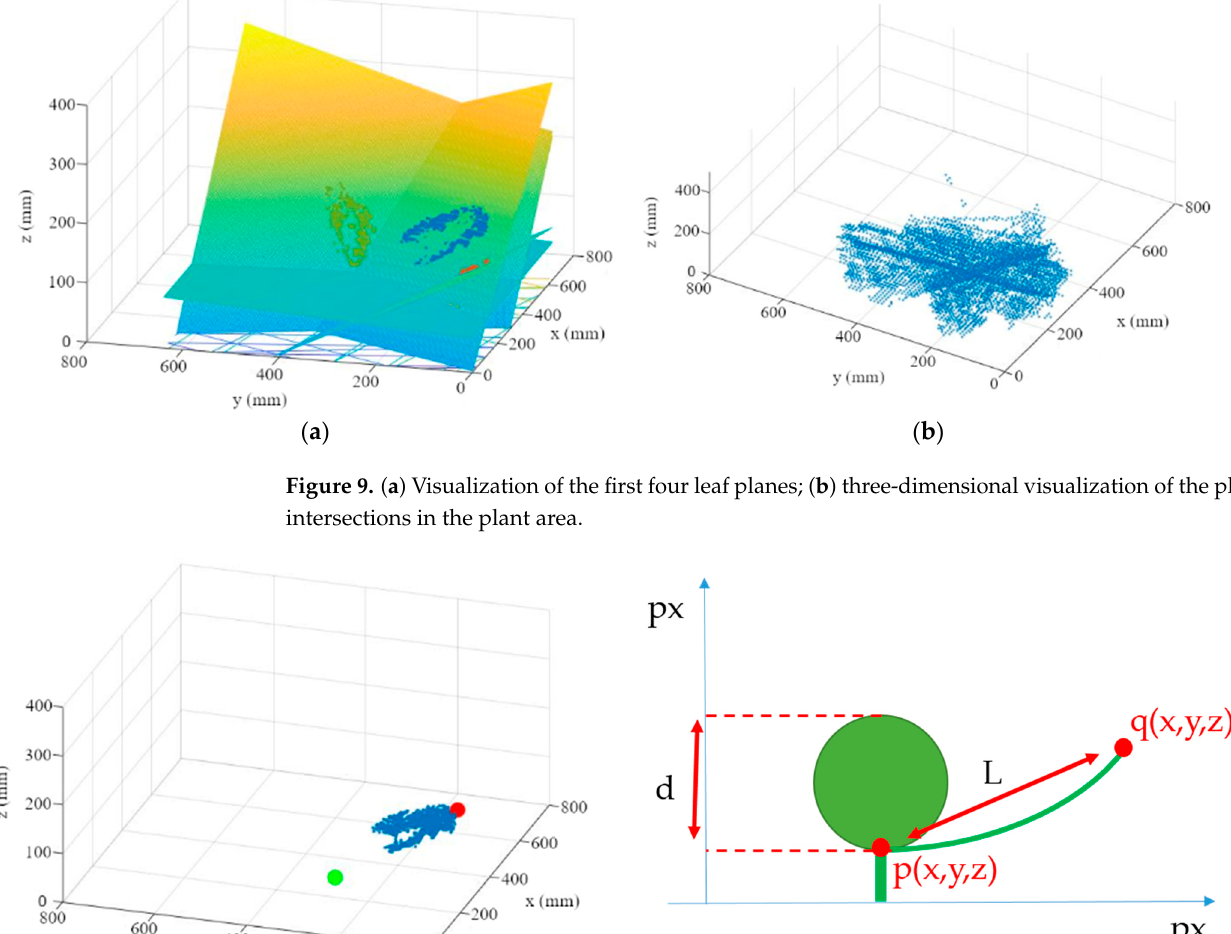
Figure 9. ( a ) Visualization of the first four leaf planes; ( b ) three-dimensional visualization of the plane intersections in the plant area .